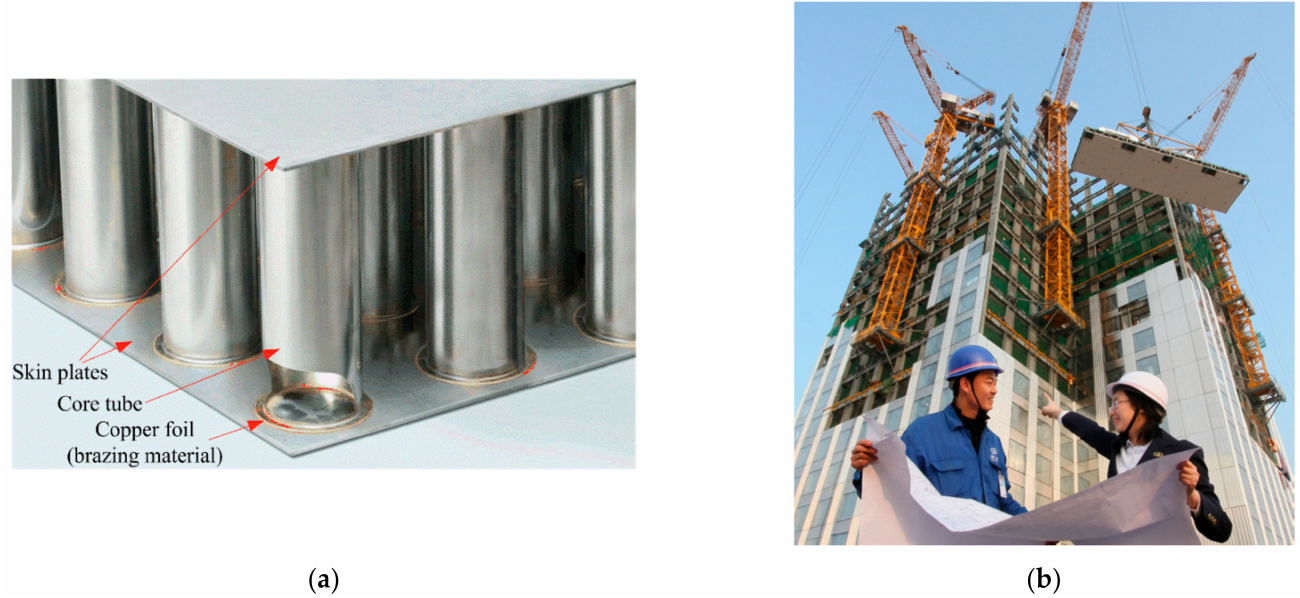
Figure 1. ( a ) Structure of the SS core panel and ( b ) the construction site of J57 Mini Sky Tower using the SS core panels. Reprinted/adapted with permission from Ref.